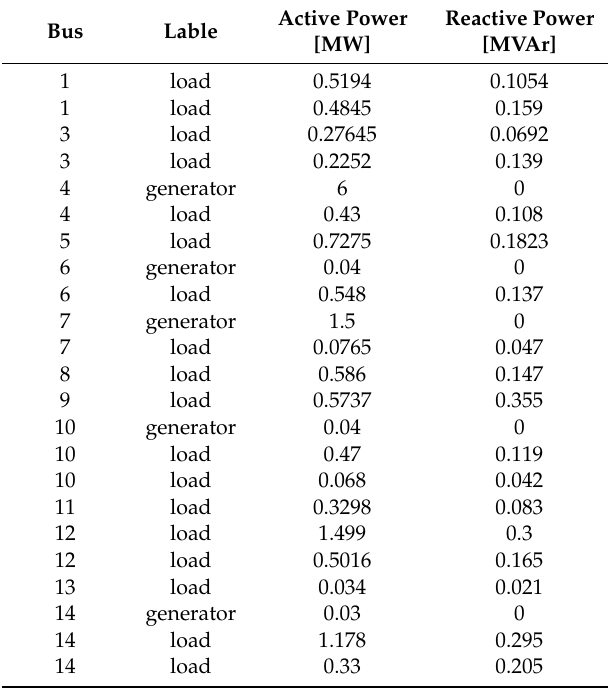
Figure 3. Topology and data of the MV distribution network. Table 1. Details on loads and generators connected to the distribution network.